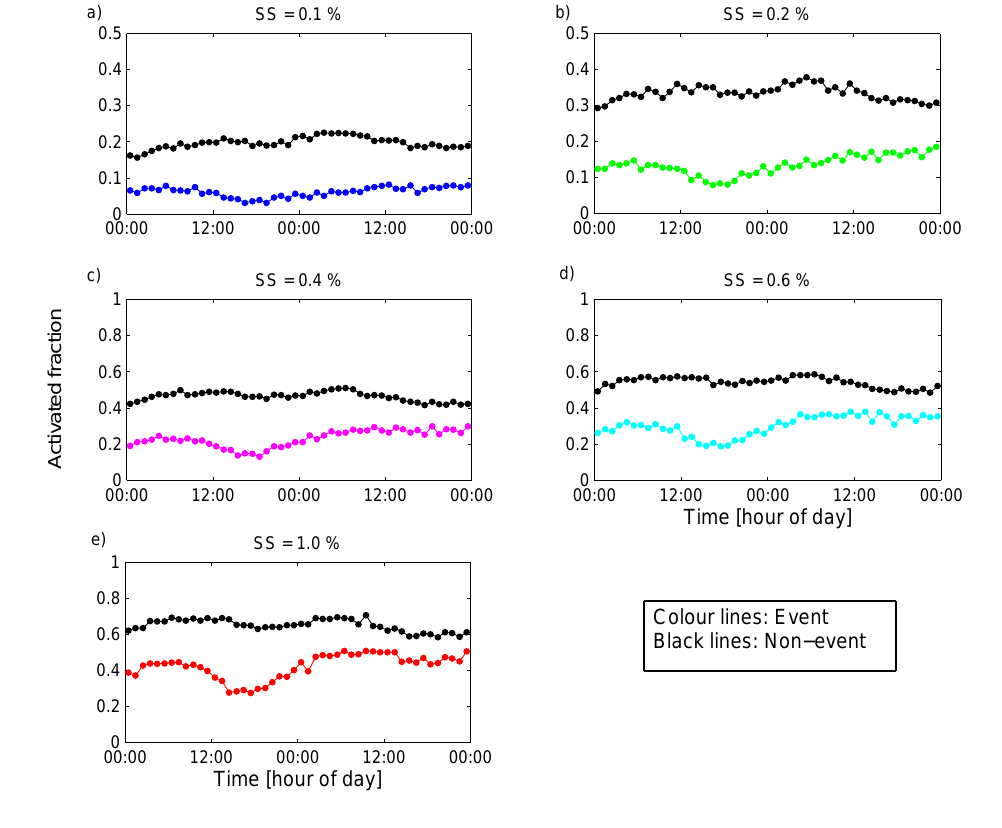
Fig. 8. Same as Fig. 7, but for the activated fraction